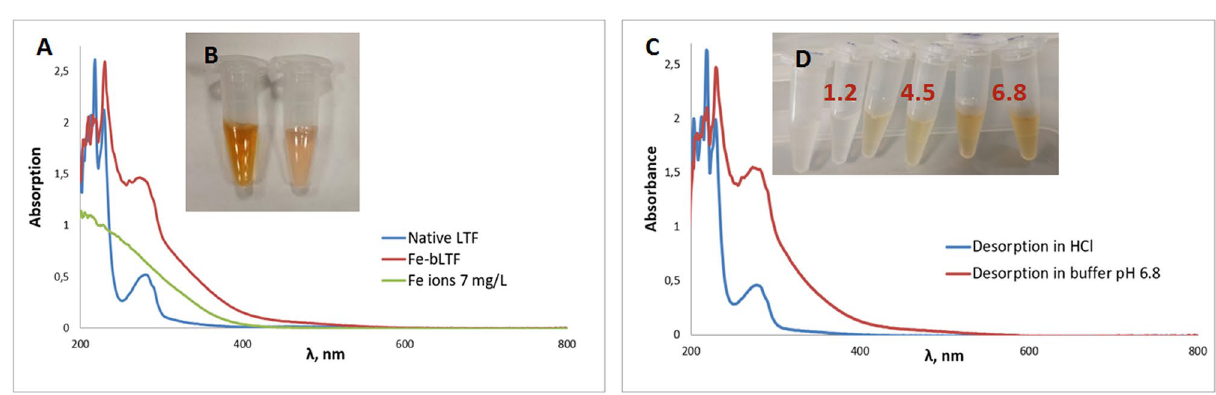
Figure 5. UV–ViS study of Fe-bLTF complexes: ( A ) spectra of native bLTF and Fe-bLTF complexes; ( B ) the solutions of Fe-bLTF complex on the right and unmodified bLTF on the left; ( C ) spectra of Fe-bLTF